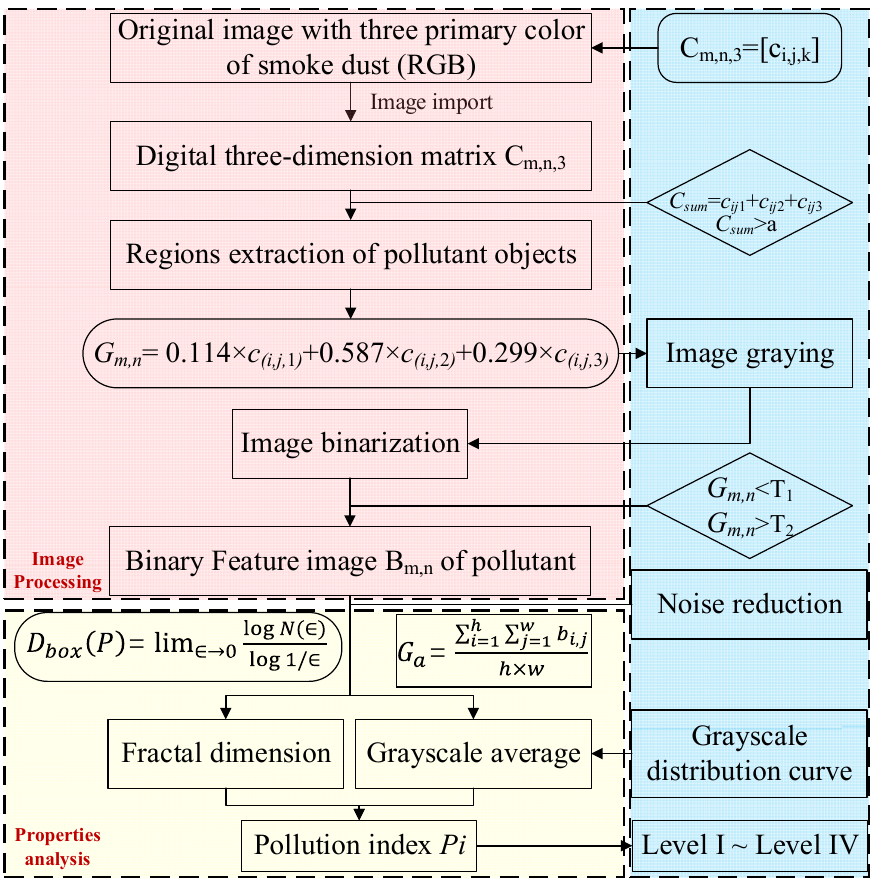
Figure 1. Flowchart of the image processing algorithms for extracting features of pollutants, and establishing an evaluation mechanism for hazards classification of smoke dust during blasting operations.